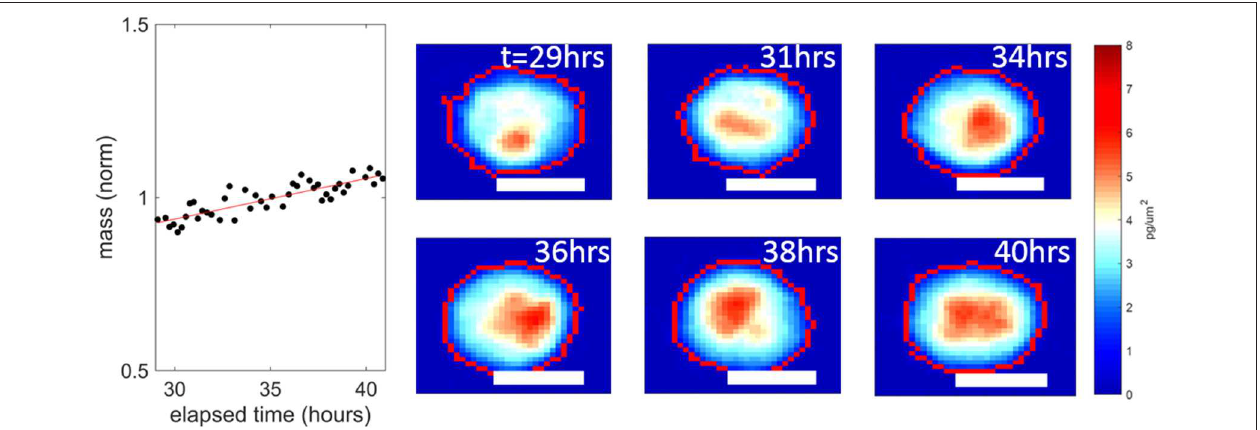
FIGURE 3 | An example UCD52 cell resistant to 1 µ M bortezomib, from the data set presented in Figure 2B . This cell continued accumulating mass a 1.2 ± 0.1% per hour over the interval 30–40h post dosing. The white scale bars are all 10 µ m.